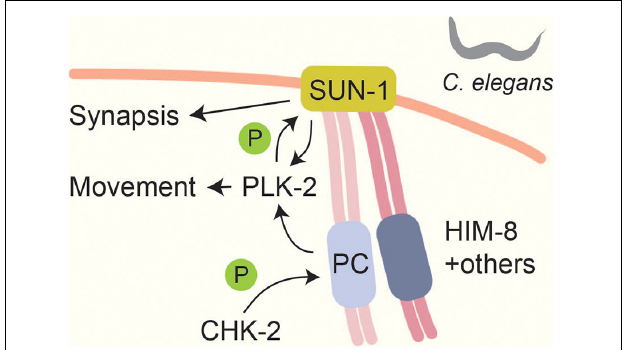
FIGURE 3 | Linking chromosome movements and synapsis in Caenorhabditis elegans . A CHK-2 mediated signal localizes pairing centers (PCs) to the nuclear envelope. CHK-2 phosphorylates PC proteins like HIM-8 at PLK binding motifs (Kim et al., 2015). This phosphorylation leads to PLK-2 localization to PCs and promotes SUN-1 phosphorylation (Penkner et al., 2009; Harper et al., 2011; Labella et al., 2011). Phosphorylation of SUN-1 stabilizes PLK-2 at PCs and is thought to be part of a checkpoint that responds to synapsis and recombination defects (Woglar et al., 2013). SUN-1 phosphorylation promotes efficient SC formation (Woglar et al.,